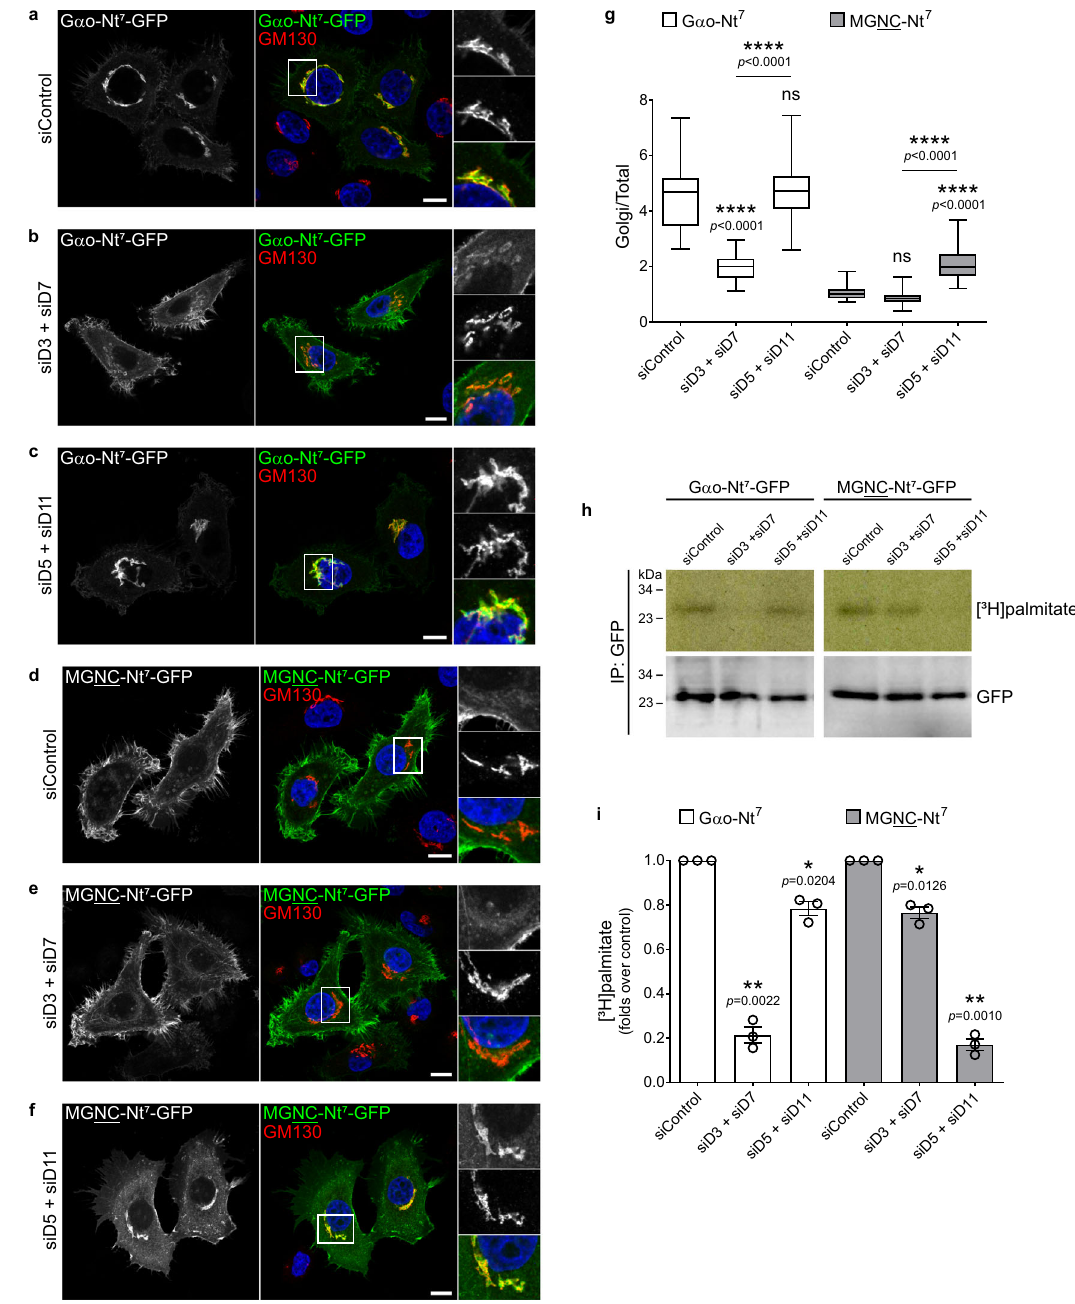
Fig. 8 Downregulation of zDHHCs affects Nt 7 compartmentalization. a – g Representative images of HeLa cells expressing G α o-Nt 7 -GFP ( a – c ) or MGNC- Nt 7 -GFP ( d – f ). Cells were previously transfected with control siRNA (siControl; a , d ), siRNAs against zDHHC3 and 7 (siD3 + siD7; b , e ), or against zDHHC5 and 11 (siD5 + siD11; c , f ). Cells were immunostained against GM130 to mark the Golgi, and nuclei were stained with DAPI in blue. Color-channels are listed vertically top-to-bottom and selected areas are magni fi ed with the channels displayed also vertically in the same order. Underlined letters indicate residues substituted in G α o-Nt 7 . Mean fl uorescence intensity ratios of GFP-constructs at the Golgi vs total cell ( g ). Box plots indicate median (middle line), 25th, 75th percentile (box), and lowest, highest value (whiskers); three independent experiments (For G α o-Nt 7 ( a – c ): siControl, n = 57; siD3 + siD7, n = 57; siD5 + siD11, n = 60. For MGNC-Nt 7 ( d – f ): siControl, n = 55; siD3 + siD7, n = 58; siD5 + siD11, n = 57). h – i Representative [ 3 H] palmitate metabolic radiolabeling of G α o-Nt 7 -GFP and MGNC-Nt 7 -GFP from cells pretreated with siControl, siD3 + siD7, and siD5 + siD11. GFP-fusions were immunoprecipitated (IP), and analyzed by autoradiography ([ 3 H]palmitate) and anti-GFP antibody ( m ). Radioactivity incorporated to G α o-Nt 7 and MGNC-Nt 7 normalized to siControl. Data shown as the mean ± s.e.m.; three independent experiments. a – f Scale bars, 10 µ m. P values were determined using one-way ANOVA Š ídák test for ( g ) and one-sample t -test for ( i ). ns: not signi fi cant. Source data are provided as a Source Data fi